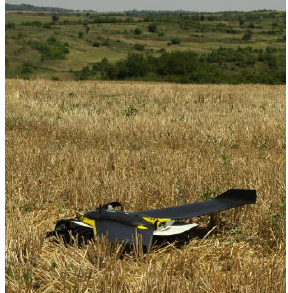
Figure 3. Preparation for the flight. eBee detecting its take-off position by receiving GNSS signals